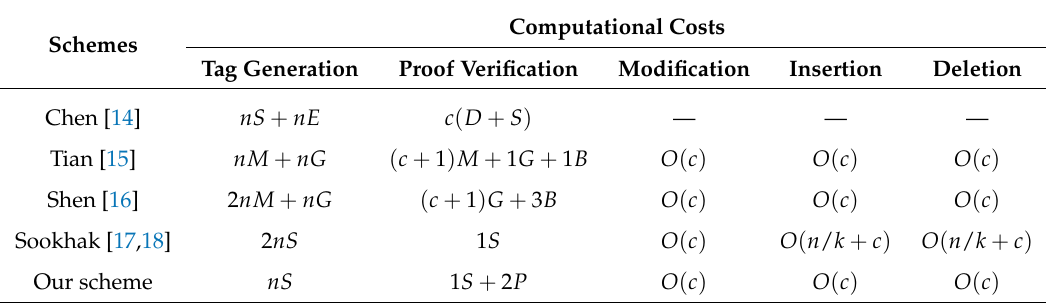
Table 2. Comparisons of computational complexity.